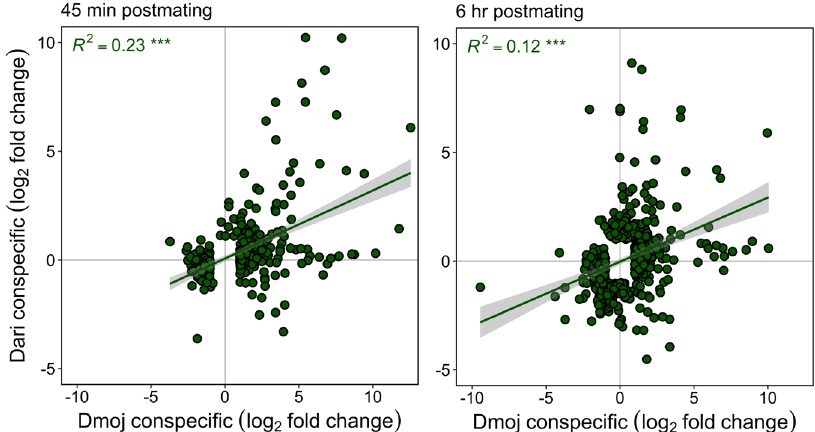
Fig. 4 Transcriptional correlations between conspeci fi c mating responsive DE genes in D. mojavensis vs D. arizonae . Scatterplots represent the relationship between relative fold changes (log 2 ) for conspeci fi c matings in D. mojavensis vs D. arizonae at 45 min and 6 h postmating. Log 2 fold changes are relative to virgin females. All conspeci fi c mating responsive genes in each species are included (FDR α = 0.05). Pearson ’ s R 2 correlation coef fi cients and linear method trend-lines (with 95% con fi dence intervals shaded) between the species are indicated. P -values of correlations are noted: *** P <